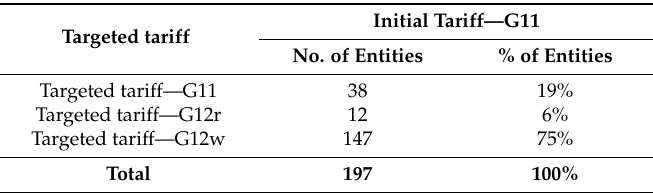
Table 2. Targeted customers tariff groups.